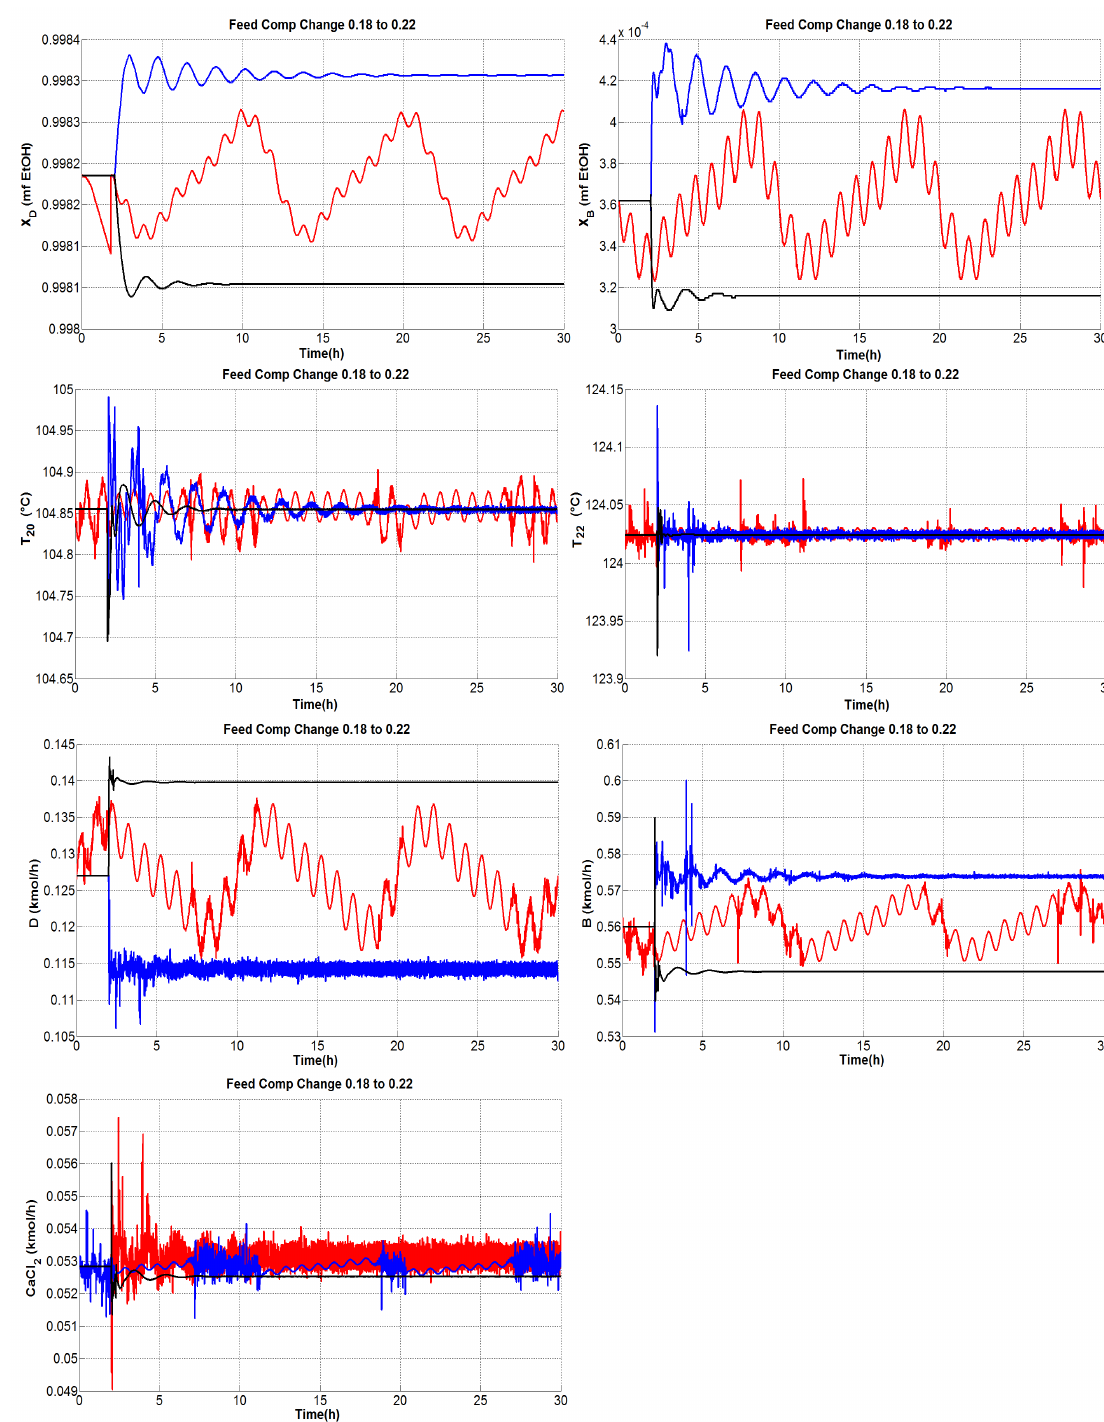
Figure 12. Performance of the RV structure for dual temperature control assuming step perturbations of the feed molar fraction with amplitude of 10% (black) and − 10% (blue) with respect to the nominal value, and a continuous fluctuating perturbation